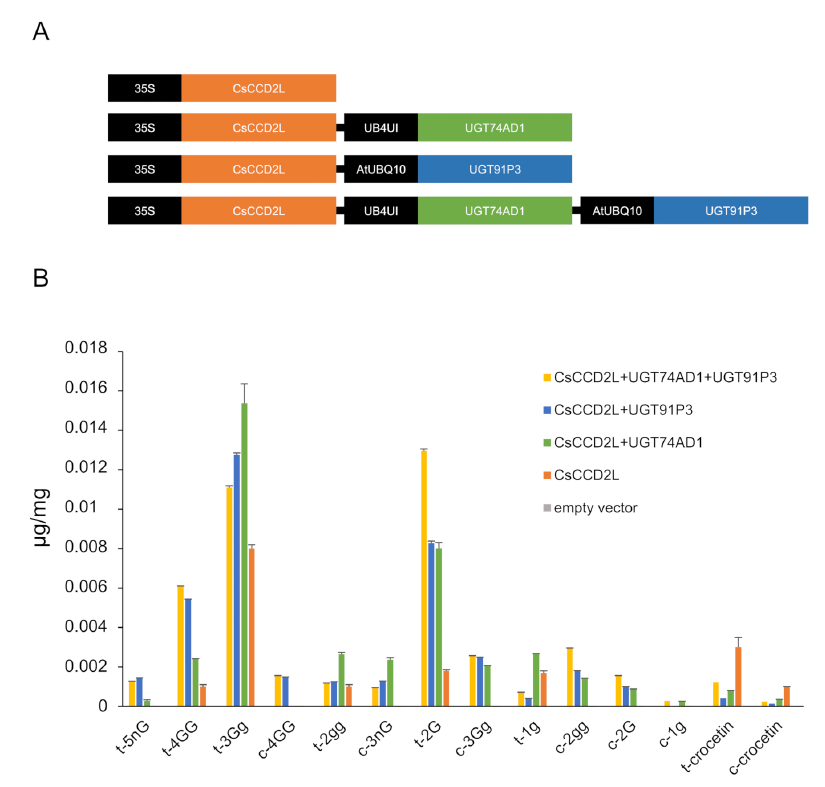
Figure 6. N. benthamiana leaves transiently expressing different constructs for crocin production. ( A ) Constructs used for transient expression analyses. ( B ) Tobacco leaves were infiltrated with Agrobacterium transformed with different constructs. Leaves were collected 8 days after infiltration. Metabolites were extracted with methanol:water (50:50), analyzed by LC-HESI-HRMS, and identified based on standard co-elution and their fragmentation patterns. Data are represented as avg std. dev. of at least 3 biological